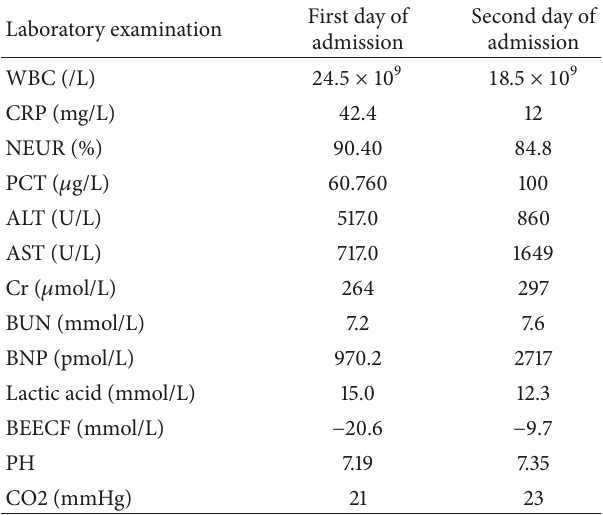
Table 1: Evidence supporting the diagnosis of septic